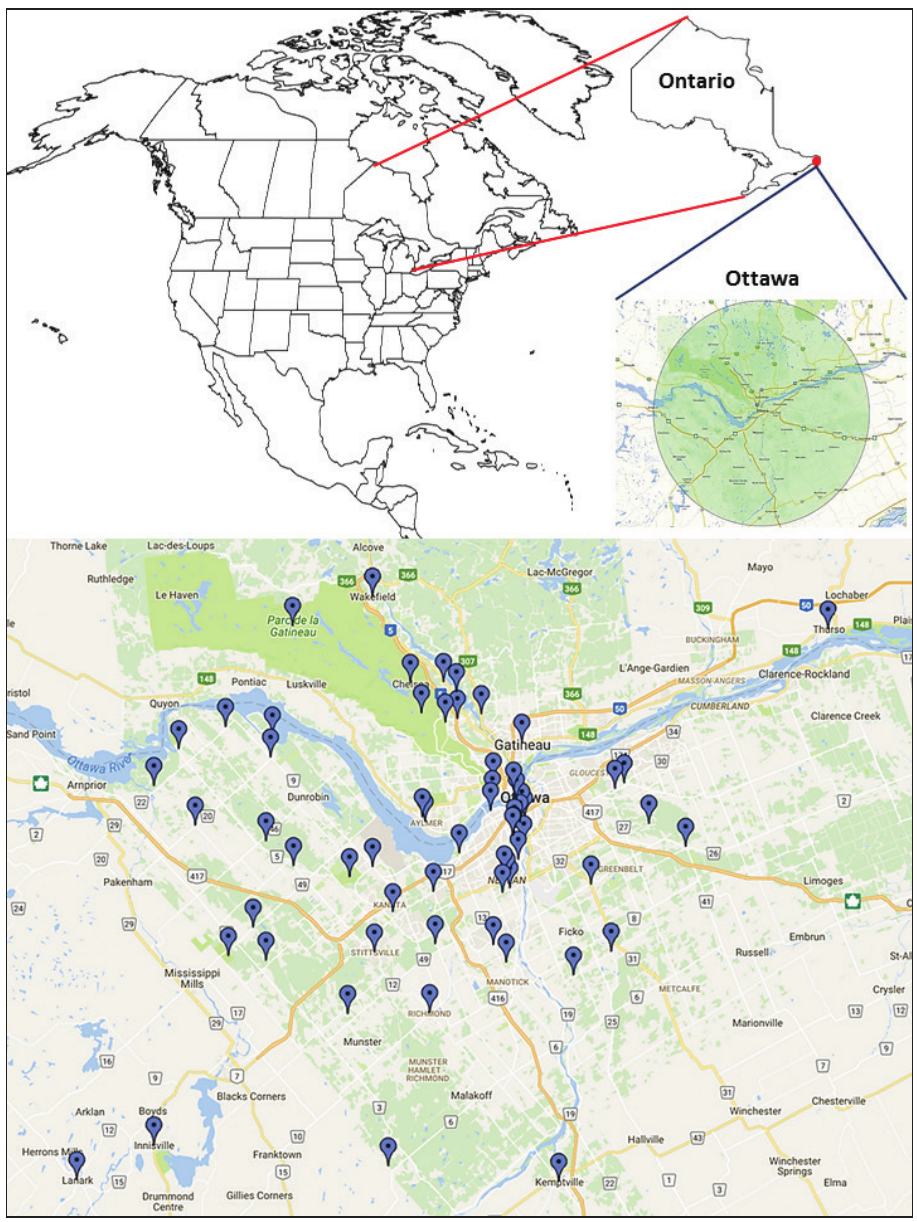
Figure 1. Localities within the city of Ottawa and surroundings where specimens of Microgastrinae were collected (1894–2010, data based on CNC holdings